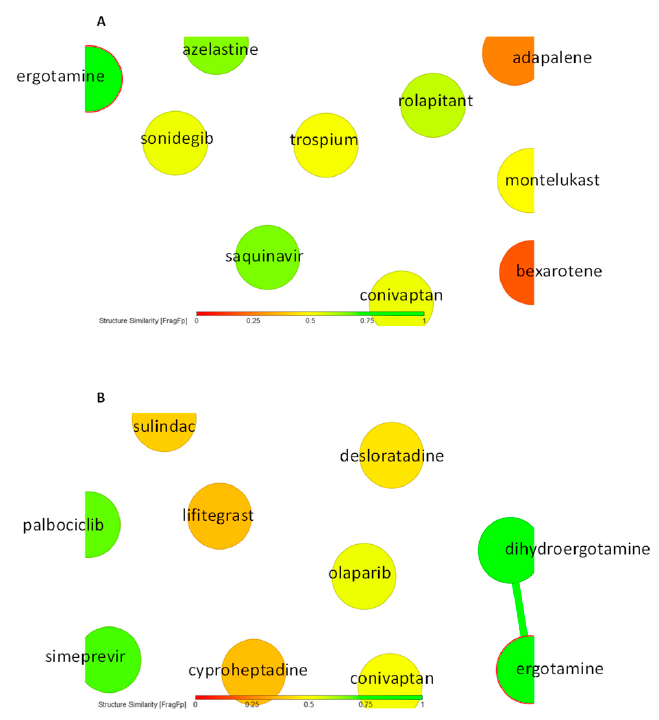
Figure 4. Similarity-based analysis of ( A ) top 10 FDA-approved drugs after HMOX1 screening and ( B ) top 10 FDA-approved drugs after PRKCA screening.